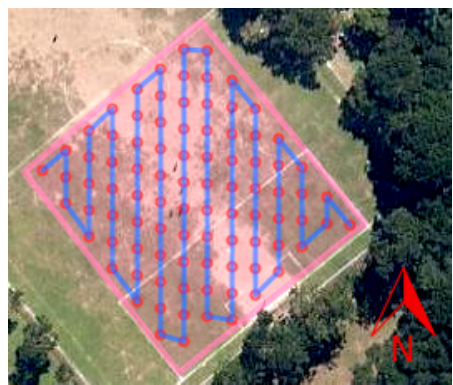
Figure 7. Example of generated path following magnetic north, with 5 m spacing between samples. The pink area is the region of interest, the blue lines are the expected path to be followed and the red circles are the discrete waypoints to visit.